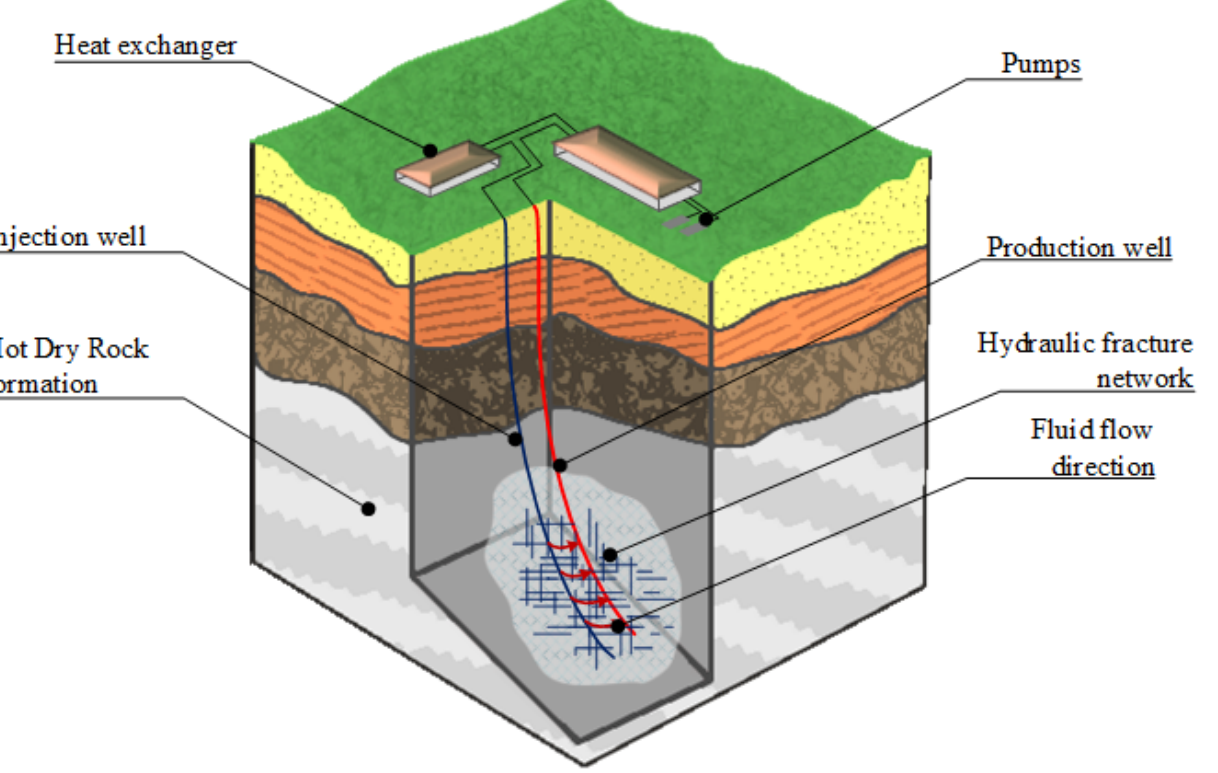
Figure 1. A typical enhanced geothermal system setup with a doublet of deviated wells